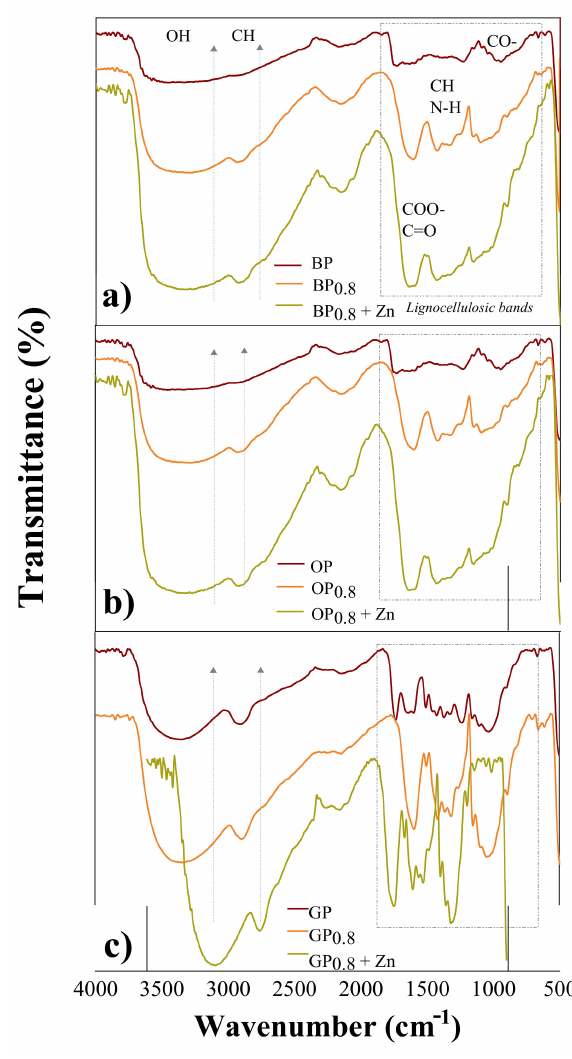
Figure 2. FT-IR spectra for ( a ) banana (BP), ( b ) orange (OP), and ( c ) granadilla (GP) bio-adsorbents before and after chemical treatment and the Zn(II) ion